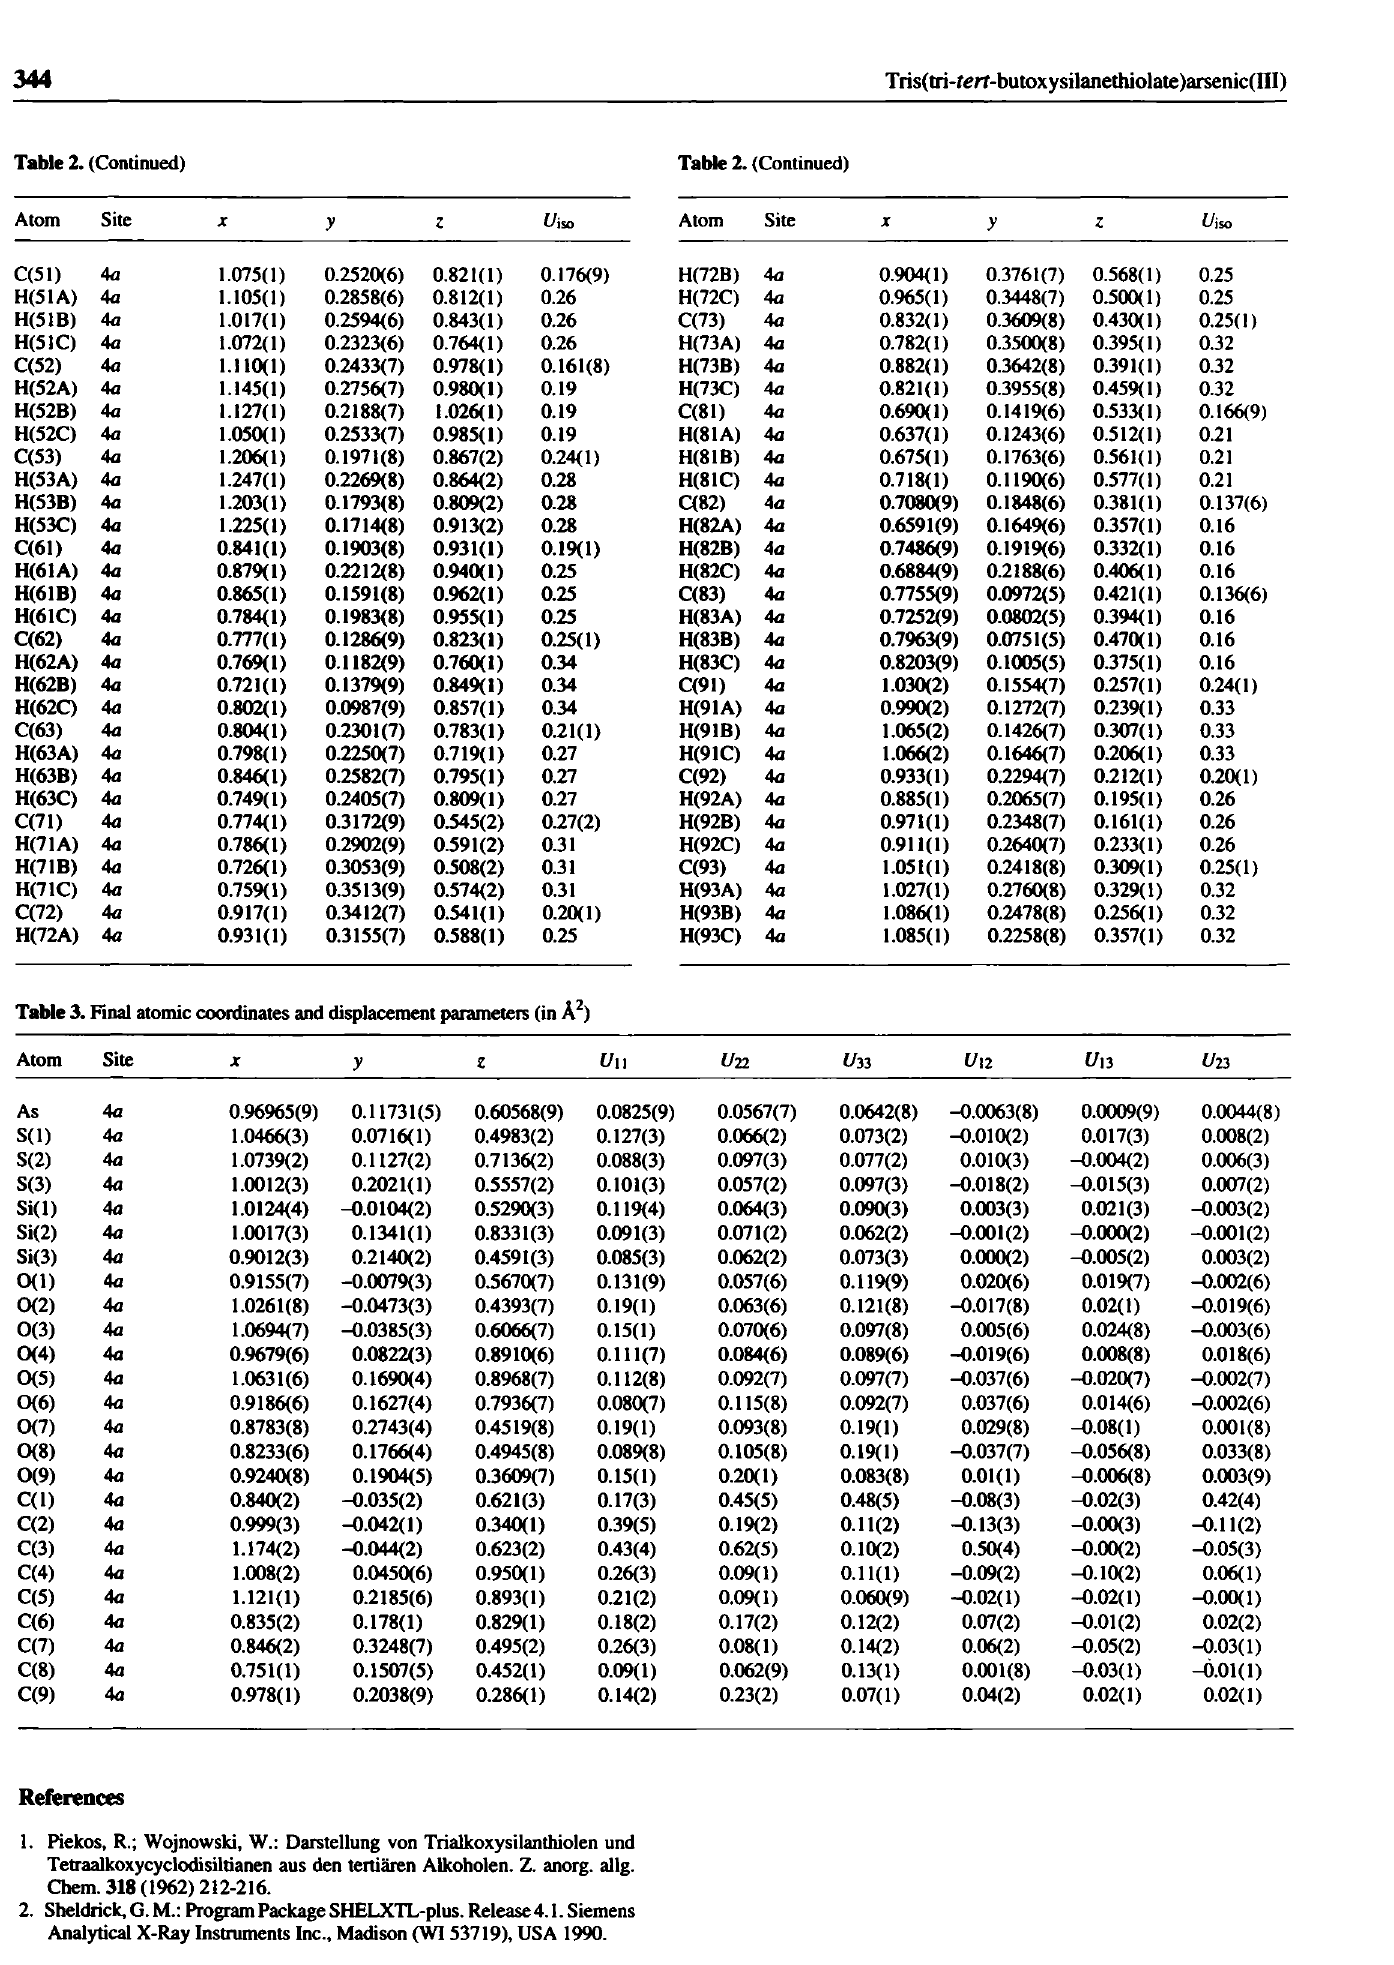
Table 3. Final atomic coordinates and displacement parameters (in Â 2